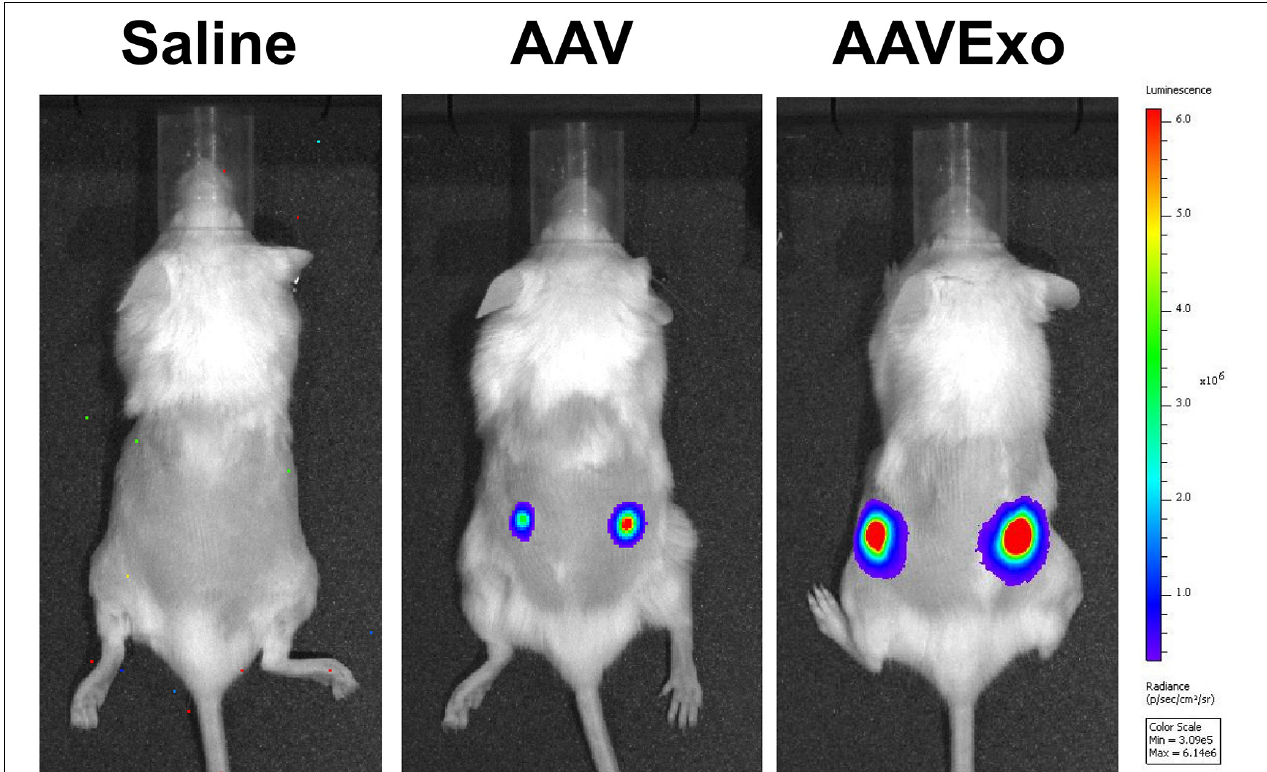
FIGURE 6 | AAVExo has stronger gene-transfer efficacy in vivo . Male NOD SCID mice aged 4–6 weeks were subcutaneously implanted with A549 cancer cells. Four weeks later, equal titer (5E9 g.c.) of AAV6Exo-luciferase, AAV6-luciferase, or saline was directly injected into the tumor. One week later, bioluminescence was recorded by IVIS